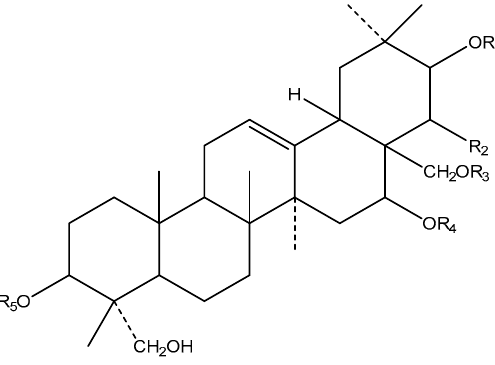
Figure 11. Basic molecular structure of Gymnemic acid.